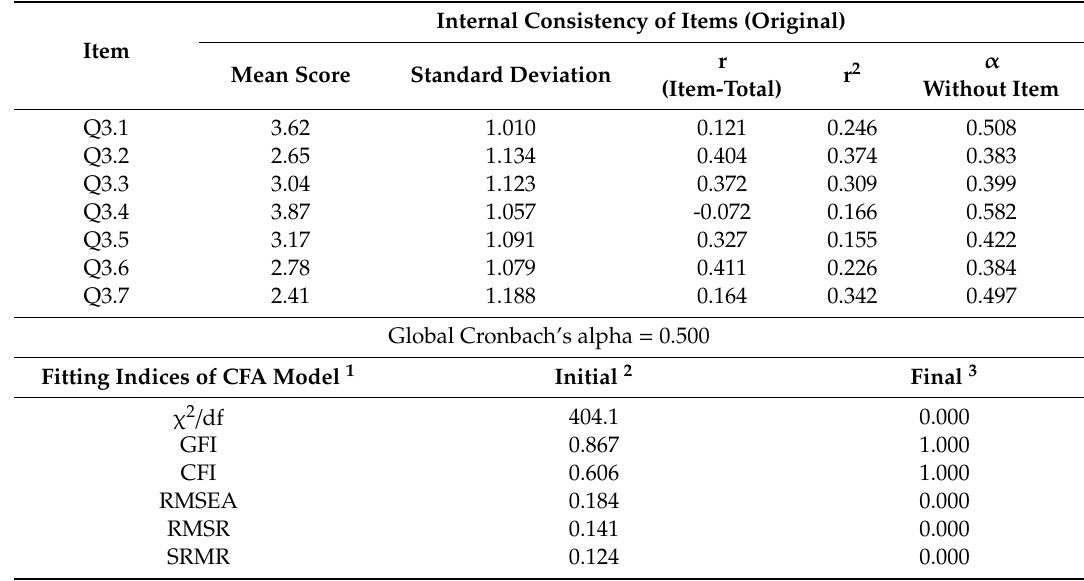
Table 3. Statistics for the unidimensional model of the scale about economic and availability motivations.